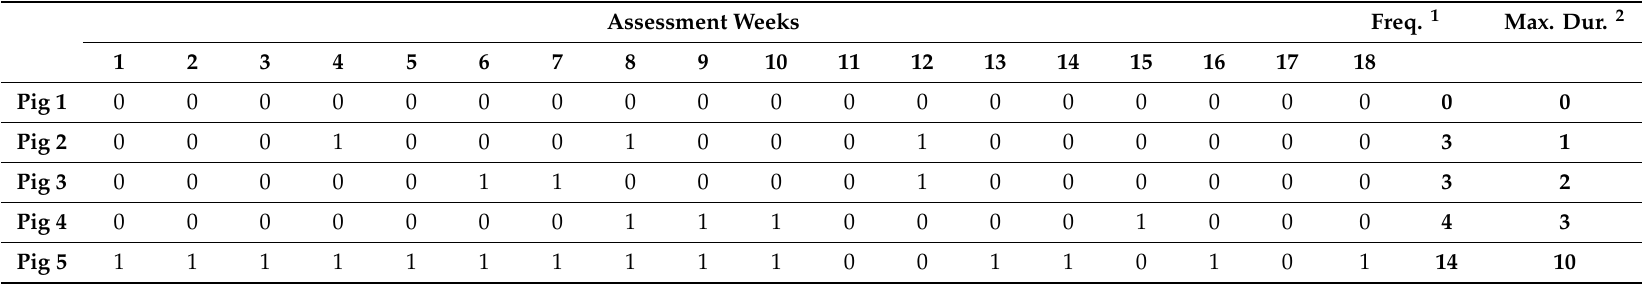
Table 1. Examples of the tail lesion scoring, frequency of score “1”, and maximum duration (1 = a tail lesion was scored; 0 = no tail lesion was scored). 1 Frequency of score “1”; 2 maximum duration of score